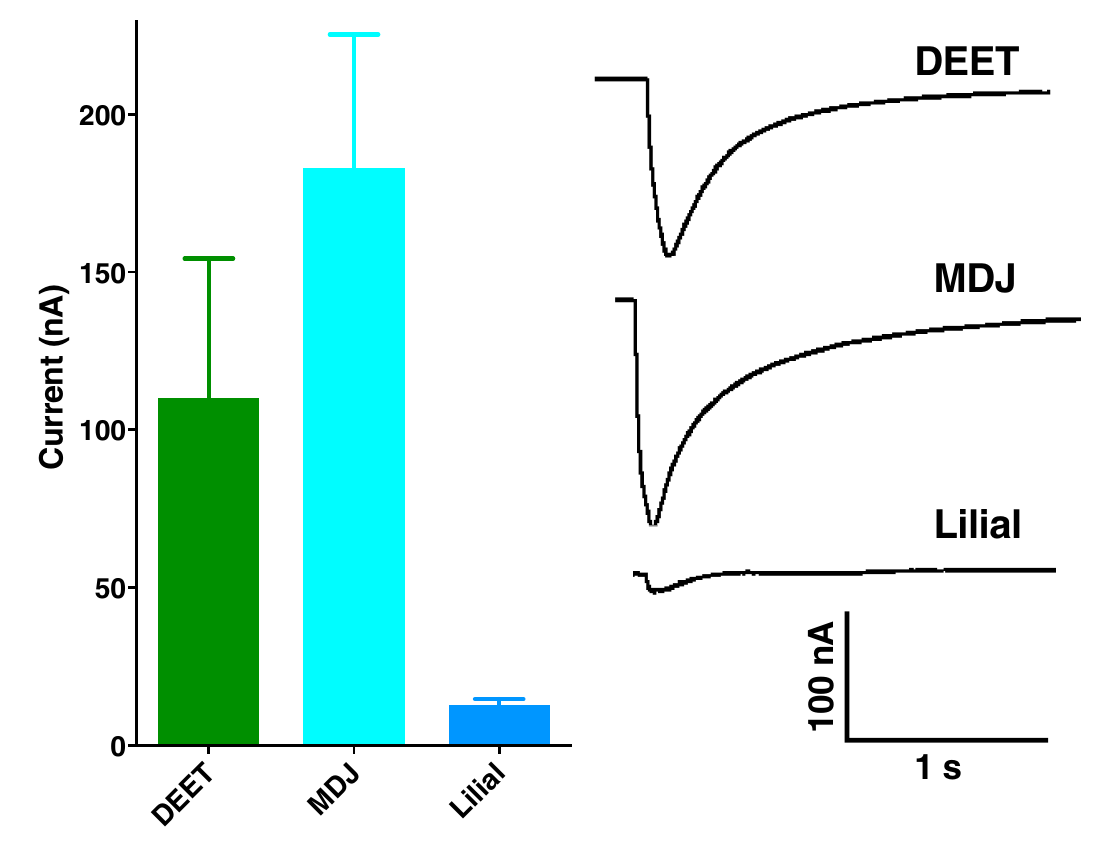
Fig 4. Responses elicited by MDJ and lilial on Xenopus oocytes expressing CquiOR136/CquiOrco. (A) Quantification of currents and (B) Representative traces obtained with the same oocyte. DEET was applied as a positive control. All compounds were tested at the same dose (1 mM). The data are expressed as mean ±